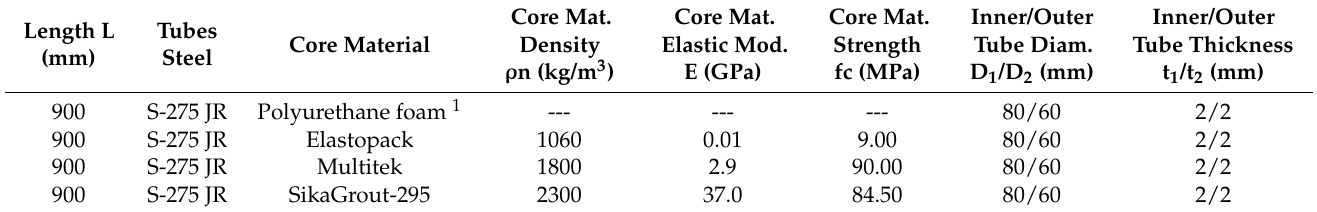
Table 1. Characteristics of the hybrid tubular elements studied.